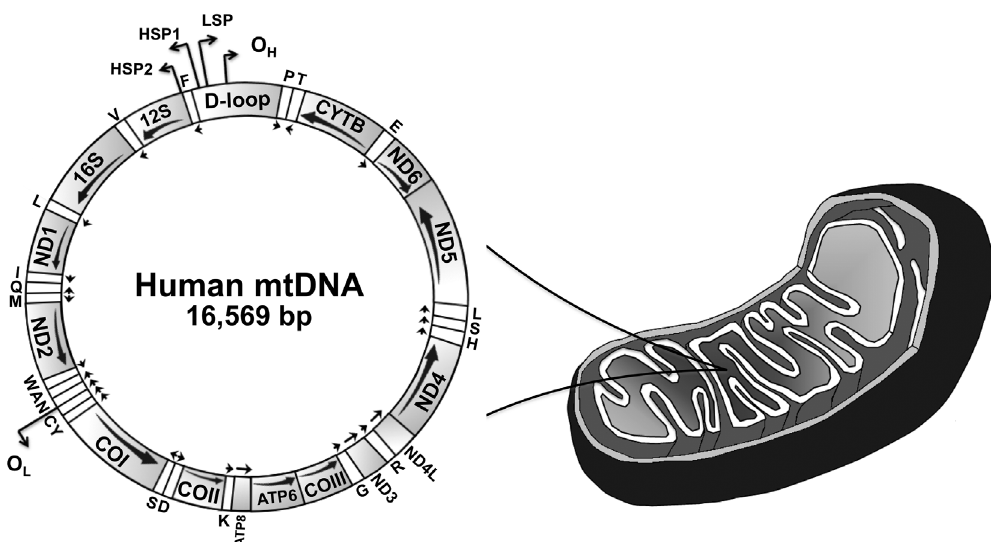
Figure 1 - Schematic representation of the human mitochondrial genome. This genome represents a typical gene content found in animal mtDNAs. The major non-coding region of mtDNA is denoted as “D-loop”. The arrows below each gene indicate the direction of transcription. Transfer RNA genes are indicated by one-letter symbols, and the 12S and 16S ribosomal RNA genes appear as 12S and 16S, respectively. CYTB, gene coding for cytochrome b; COI-III,subunitsI-IIIofcytochromecoxidase;ND1-6,subunits1-6ofNADHdehydrogenase;ATP6and8,subunits6and8ofATPsynthase;O H ,origin of heavy (leading) strand synthesis; O L , origin of light (lagging) strand synthesis, according to the strand-displacement model of mtDNA replication (see text and Figure 2 for details); LSP, light strand promoter; HSP1 and 2, heavy strand promoters 1 and 2 (reviewed in Oliveira et al. ,